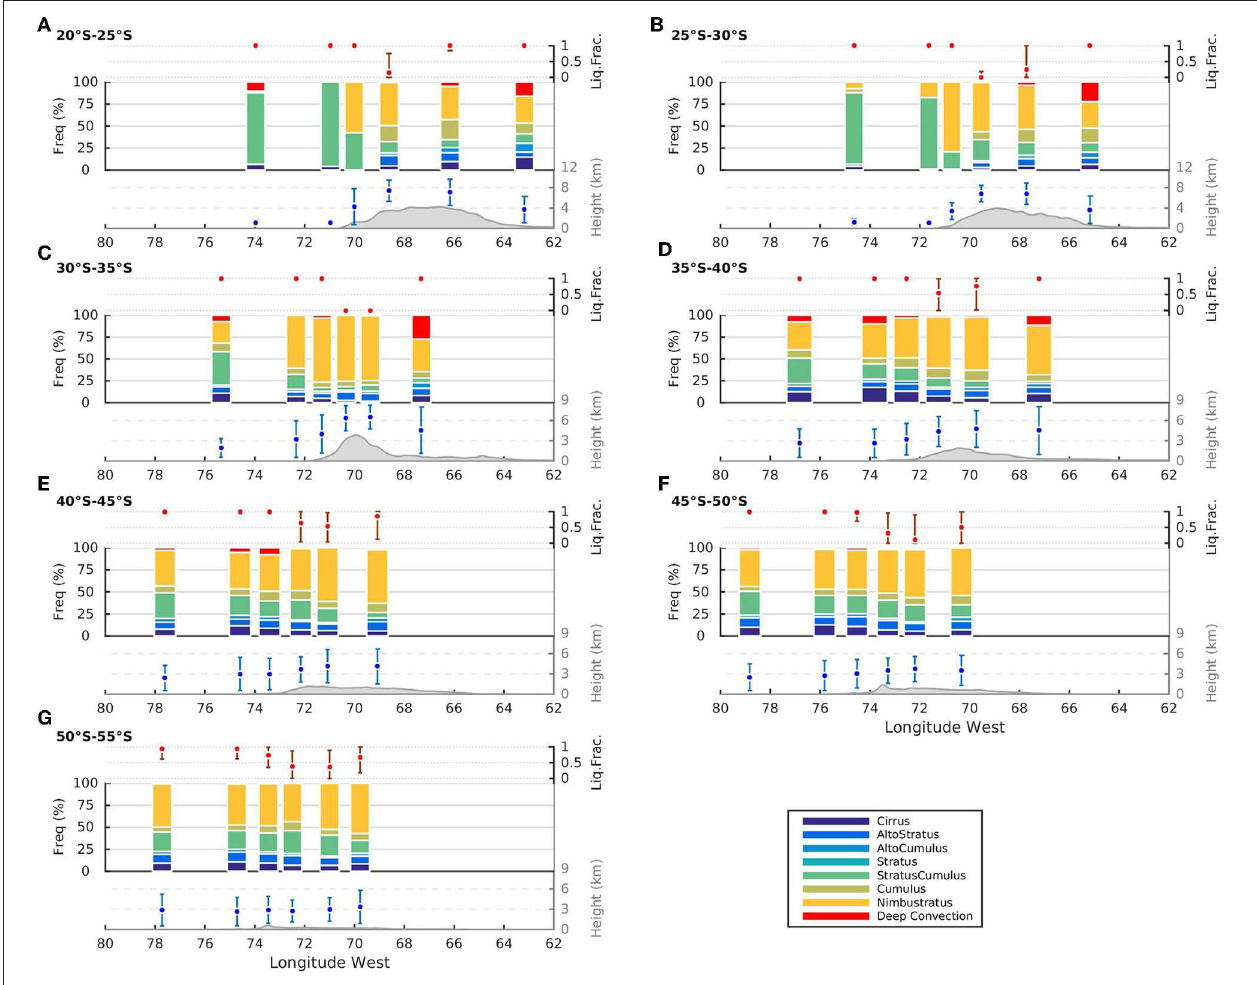
FIGURE 8 | Total mass fraction of liquid water contained in surface precipitation (median and interquartile values in the top panels), percentage of cloud types (%, middle panels), and mean elevation of cloud deck and cloud depth (bottom panels) during precipitating profiles observed by the CloudSat satellite over the 2006–2016 period in different cross-barrier zones (open ocean, coast, upstream, upslope, downslope, and lee) and for different latitudinal bands: (A) 20–25 ◦ S, (B) 25–30 ◦ S, (C) 30–35 ◦ S, (D) 35–40 ◦ S, (E) 40–45 ◦ S, (F) 45–50 ◦ S, (G) 50–55 ◦ S. The mean cross-barrier altitude of the Andes is plotted in each transect for reference. Note that the y-axis changes the scale in different panels to highlight variations in cross-barrier directions. CloudSat 2B-CLOUDCLASS and 2C-PRECIP-COLUMN products are